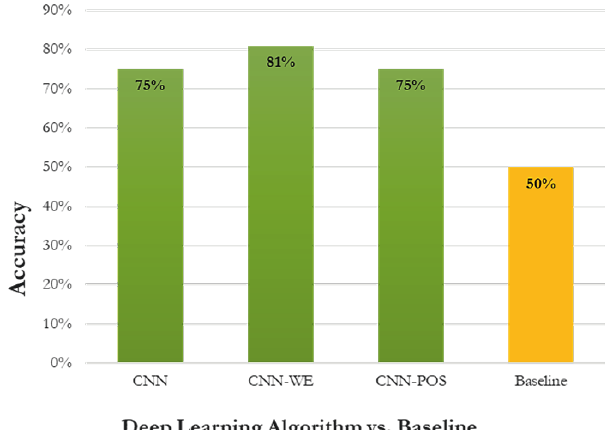
Fig. 5. Accuracy of DL models vs. baseline model for the sentiment classification phase. A comparison of all machine learning applied models with the deep learning models is shown below in Fig. 6. Fig. 7 shows the plot graph of training accuracy and validation over epochs. The epochs are represented as the row x and the accuracies are represented as the column y. We can see that the model in Word Embeddings algorithm was rising for the epochs and achieved accuracy of 81 %.